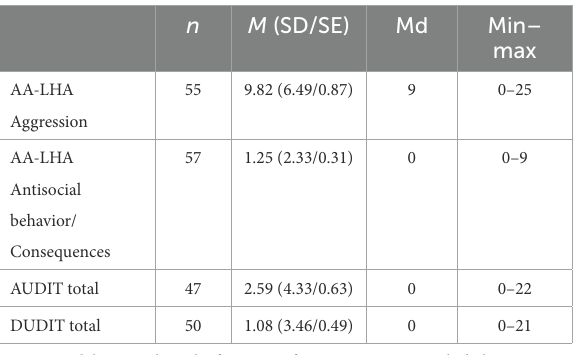
TABLE 3 Self-reported risk behaviors among non-binary adolescents ( N = 58).